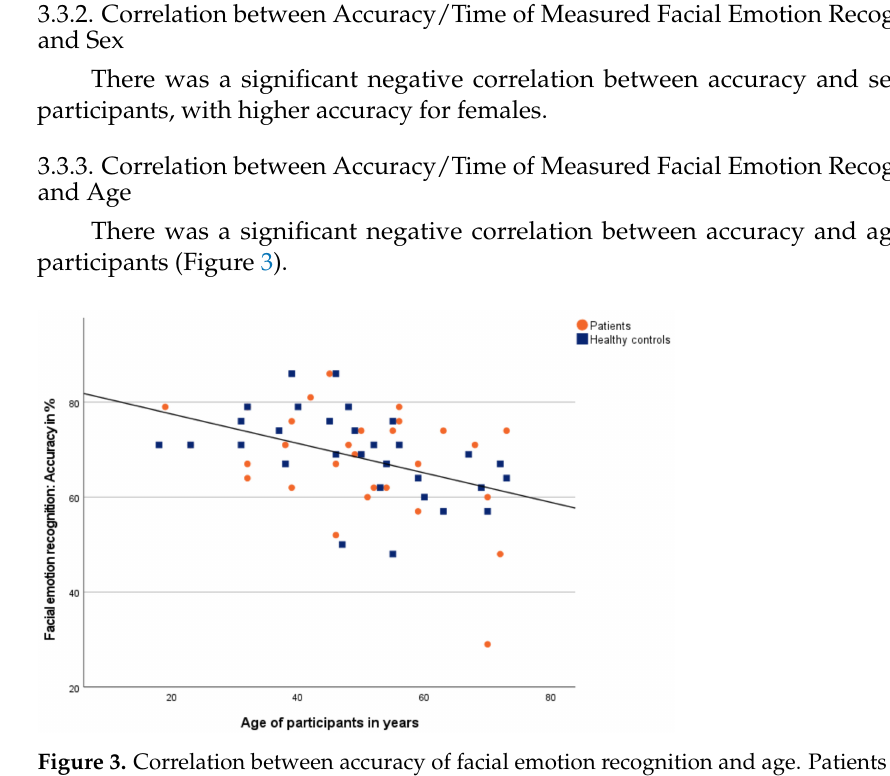
Figure 3. Correlation between accuracy of facial emotion recognition and age. Patients are shown as orange dots, and healthy controls as blue squares.